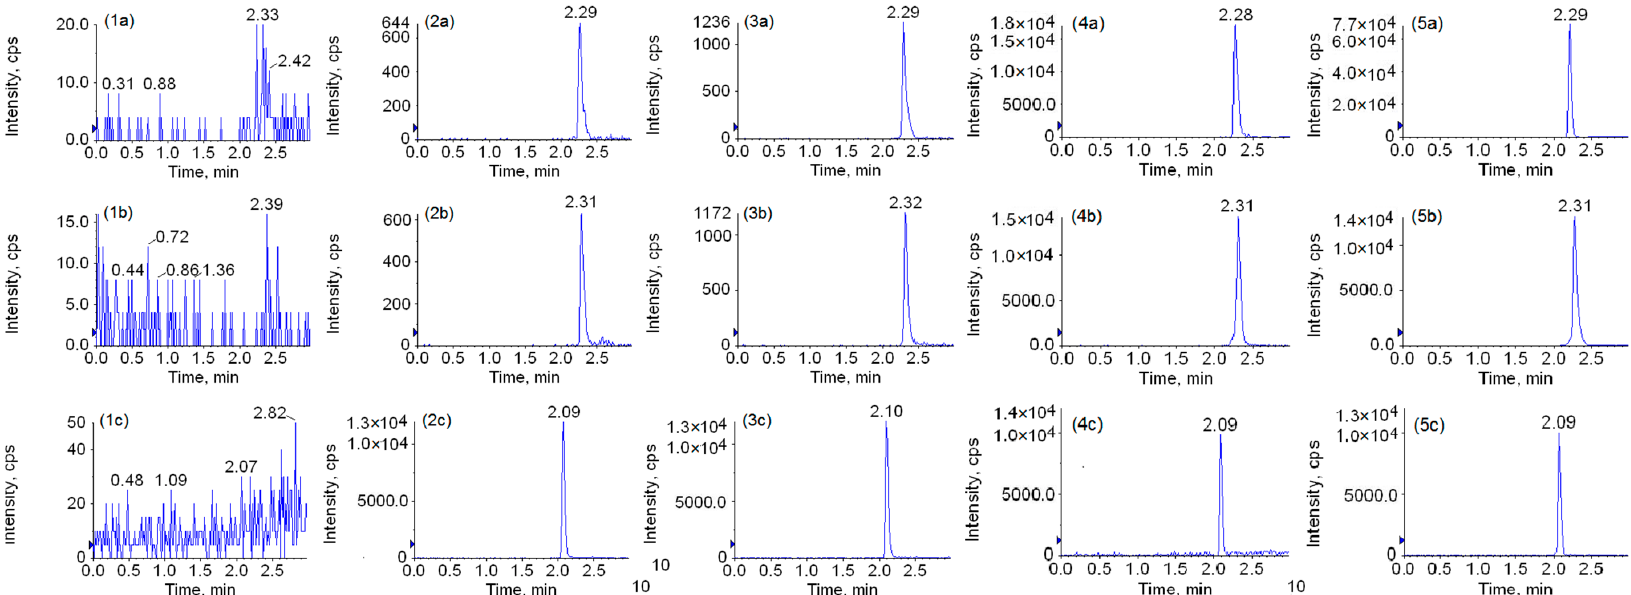
Figure 2. Representative MRM chromatograms of peimine ( a ), peiminine ( b ) and IS ( c ) in beagle dog plasma samples. Blank beagle dog plasma ( 1 ), a spiked plasma sample with the analytes at LLOQ ( 2 ), a blank plasma with IS and analytes at low QC levels (1.976 ng/mL for peimine, 1.960 ng/mL for peiminine) ( 3 ), a plasma sample taken 2 h after oral administration of 1.0 g/kg Fritillaria ussuriensis Maxim powder ( 4 ) and 1.0 g/kg Fritillaria thunbergii Miq powder ( 5